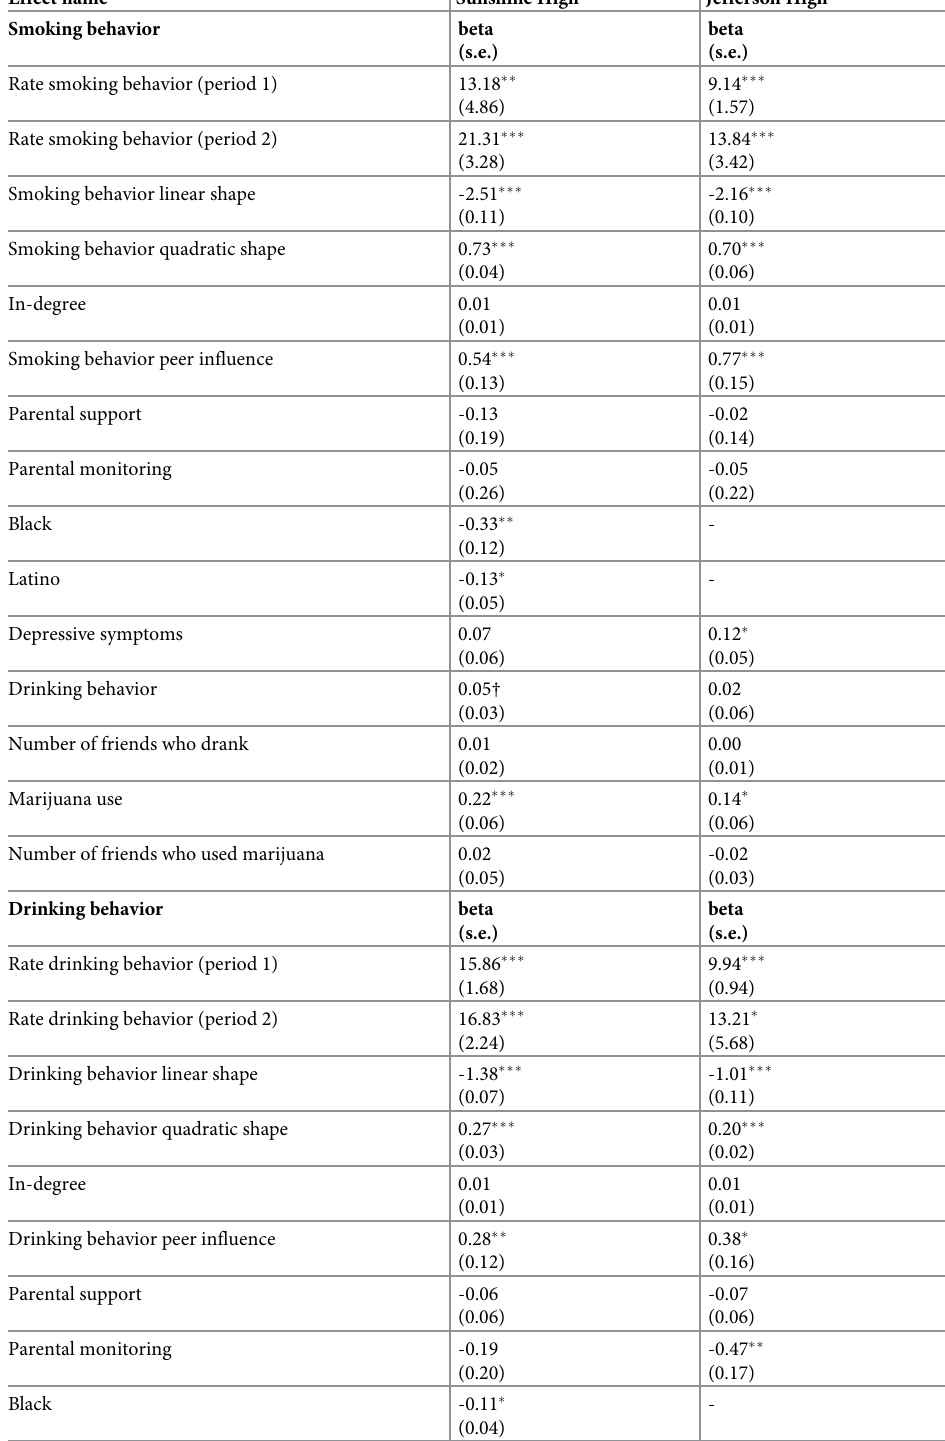
Table 2. Stochastic actor-based models of substance use of cigarettes, alcohol, and marijuana and friendship net- works with number of friends who smoked/drank/used marijuana